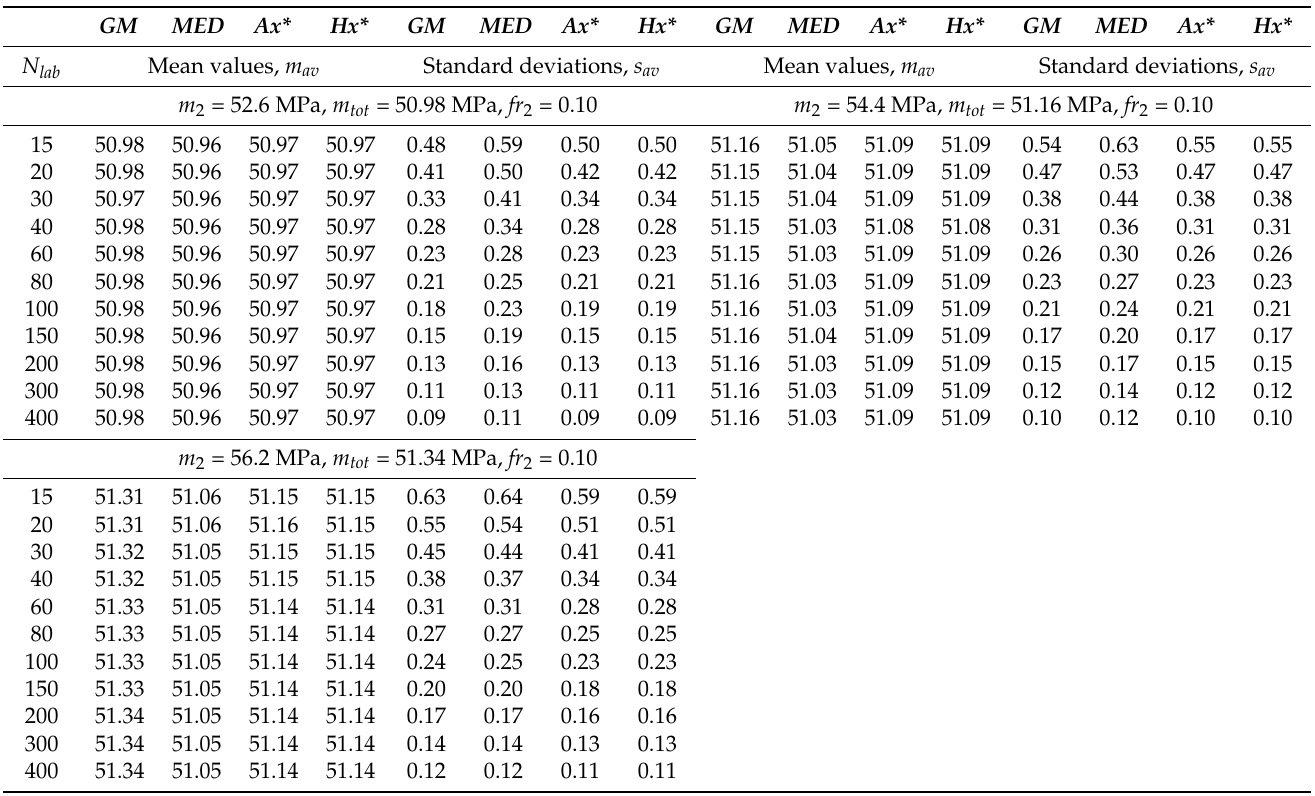
Table 3. Average and standard deviation of the mean